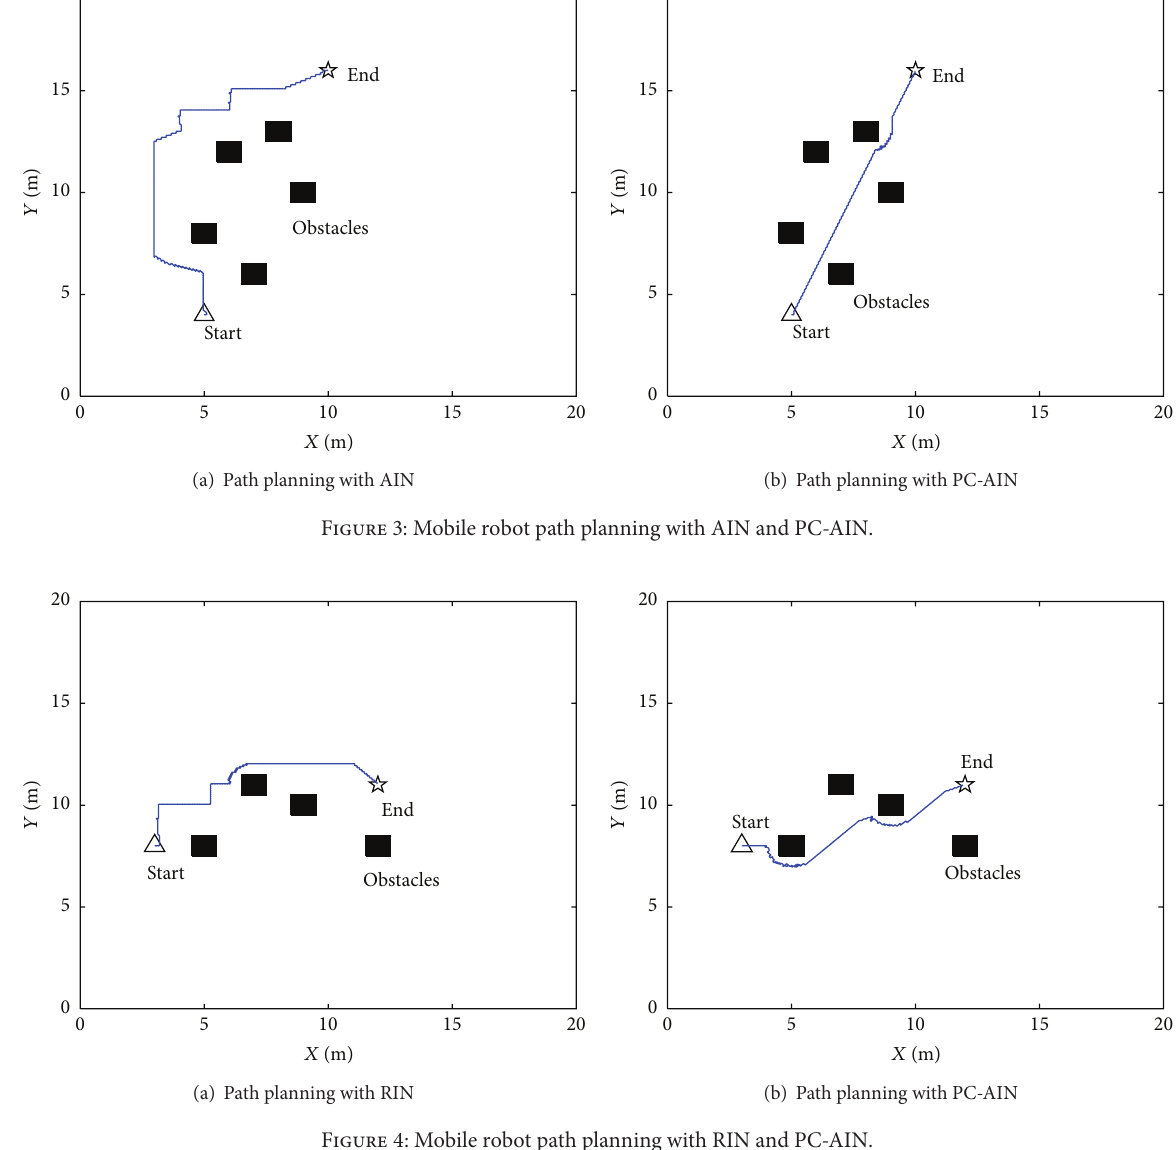
Figure 4: Mobile robot path planning with RIN and